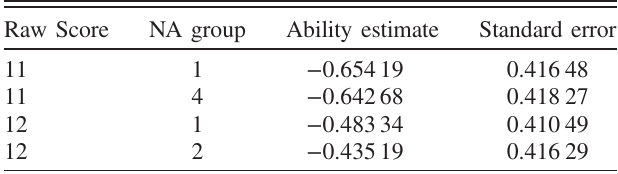
TABLE VII. Person parameters for equal scores but different number of answers submitted. NA Group ¼ all persons not submitting answers for the same items, NA Group1 ¼ persons with all answers submitted, NA Group2 ¼ persons not submitting an answer for item 8.2 , NA Group4 ¼ persons not submitting an answer for item 4.4